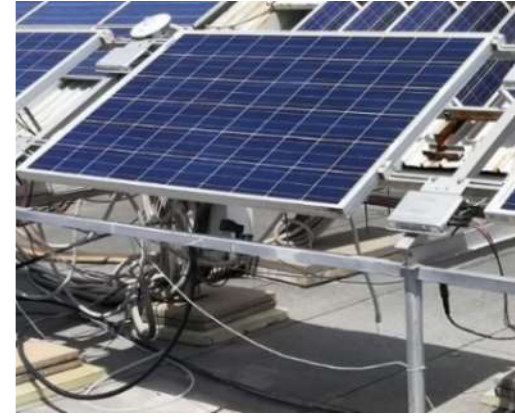
Figure 2. Experimental set-up at DIMEG—Unical. Table 1. Thermophysical characteristics of the layers